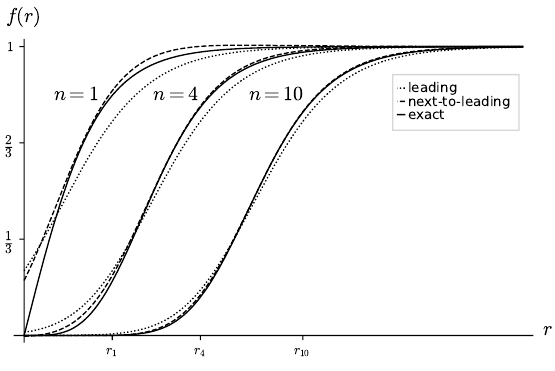
Figure 1 . The numerical solution of the exact critical vortex equations for the scalar field f ( r ) (solid lines), the leading asymptotic boundary layer solution (dotted lines), and the next-to-leading approximation (dashed lines) for different winding numbers n .